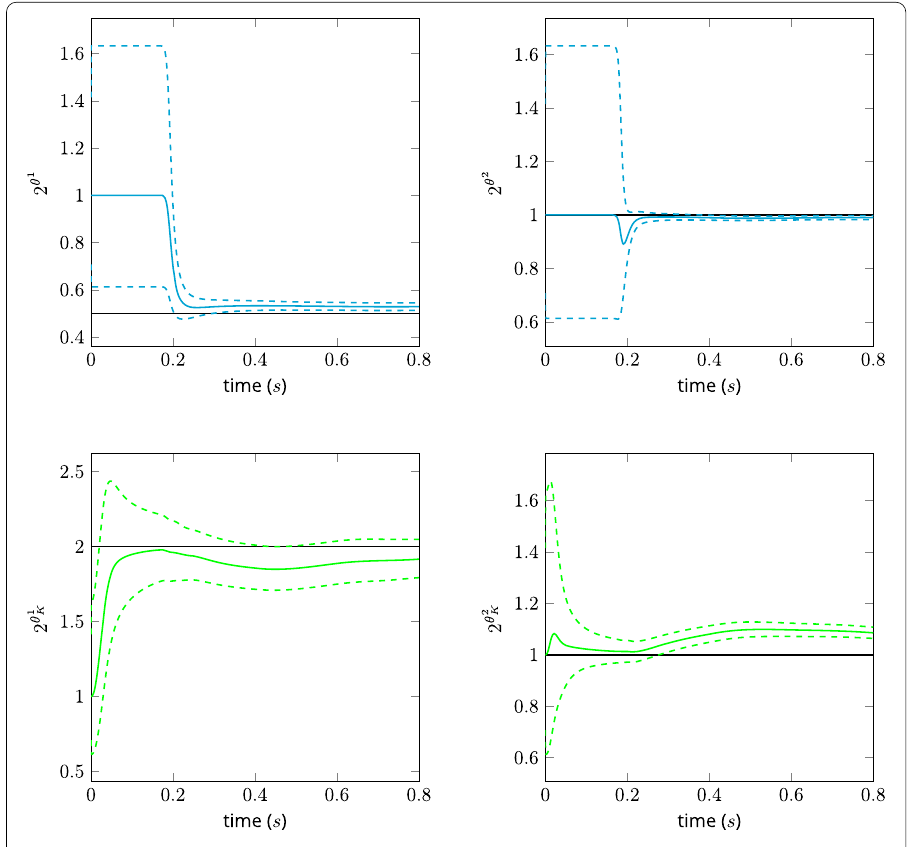
Fig. 14 Estimation of active (top) and passive (bottom) parameters using tag grids